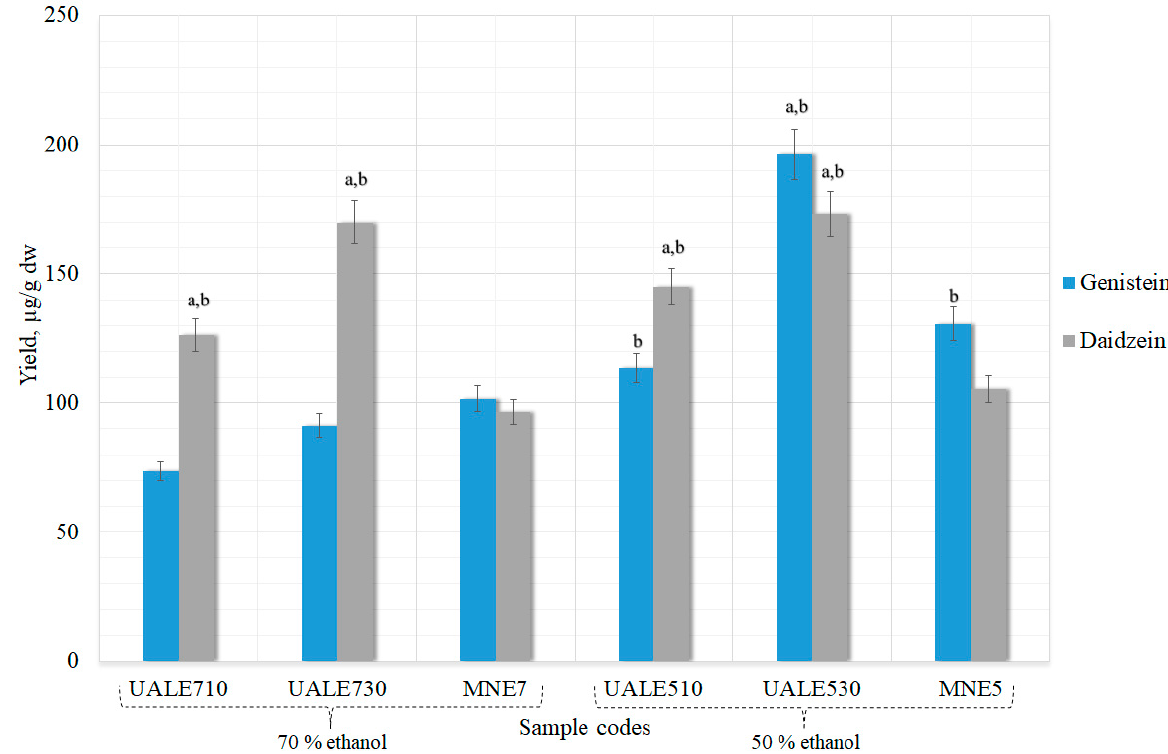
Figure 6. Influence of UAE treatment time and solvent concentration with alkaline hydrolysis on the maximal extraction yield of genistein and daidzein in extracts. a p < 0.05 vs. maceration with 50% ethanol (MNE5); b p < 0.05 vs. maceration with 70% ethanol (MNE7). Sample codes and preparation conditions are displayed in Table 1.